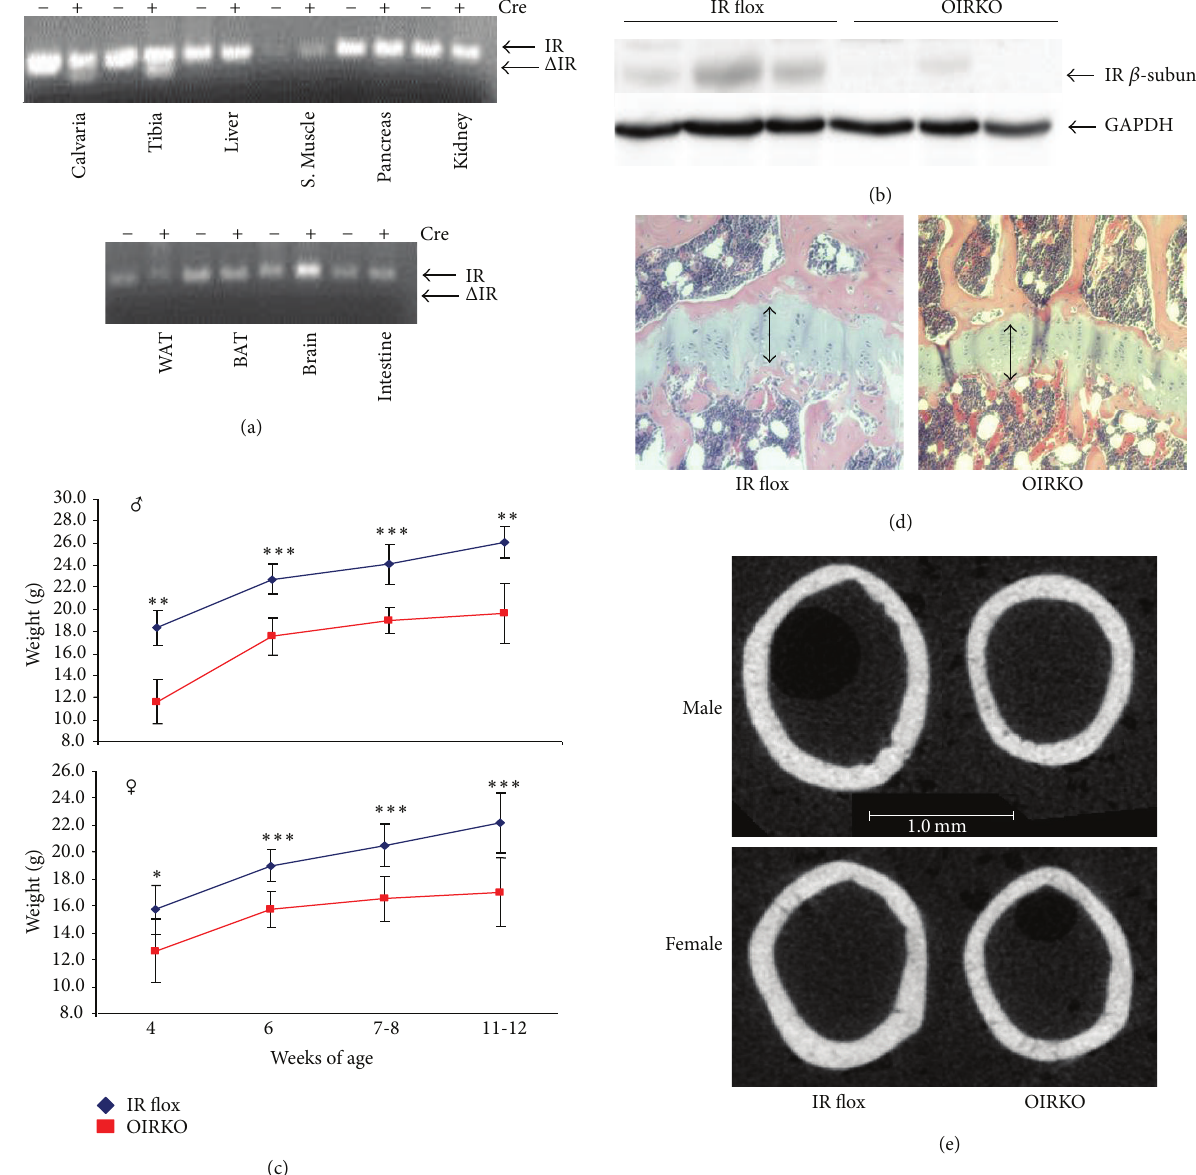
Figure 1: OIRKO mice are smaller in size, with slighter bones. PCR of the IR locus revealed that recombination of floxed IR alleles occurs only in bone ((a), Δ IR; calvaria, tibia). OIRKO mice exhibited an ∼ 80% decrease in IR in whole bone by Western blot ( 𝑛 = 3 IR flox, 3 OIRKO tibiae, (b)). Loss of the insulin receptor in osteoblasts reduced the size of male and female mice. Postnatal growth curves for male ((c), top) and female ((c), bottom) IR flox and OIRKO mice are shown ( ∗ 𝑃 < 0.05 , ∗∗ 𝑃 < 0.01 , and ∗∗∗ 𝑃 < 0.001 ). Disruption in the growth plate was not apparent (a representative H & E stain is shown, (d)). 𝜇 CT images of the femur midshaft demonstrated that femurs from OIRKO mice are narrower than from comparably aged IR flox mice